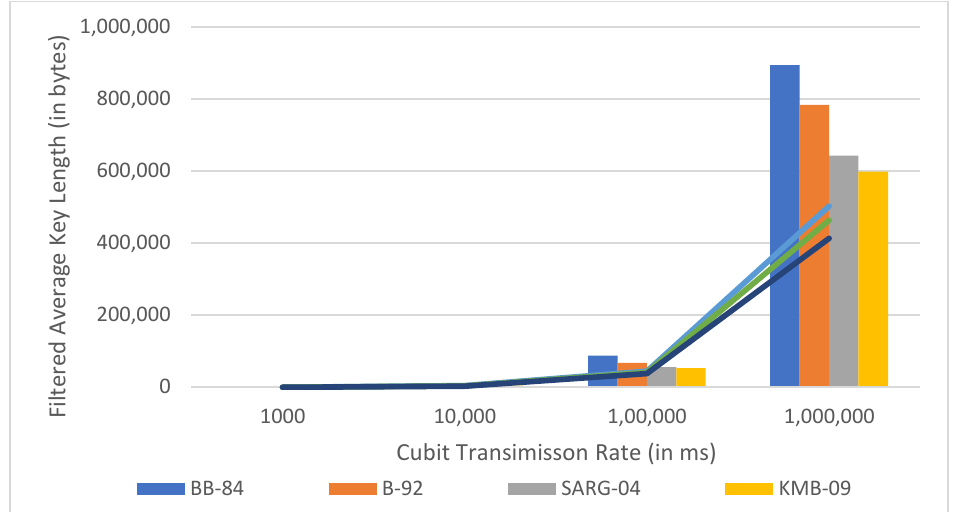
Figure 7. Comparison of the proposed model to the existing models in terms of average key length.